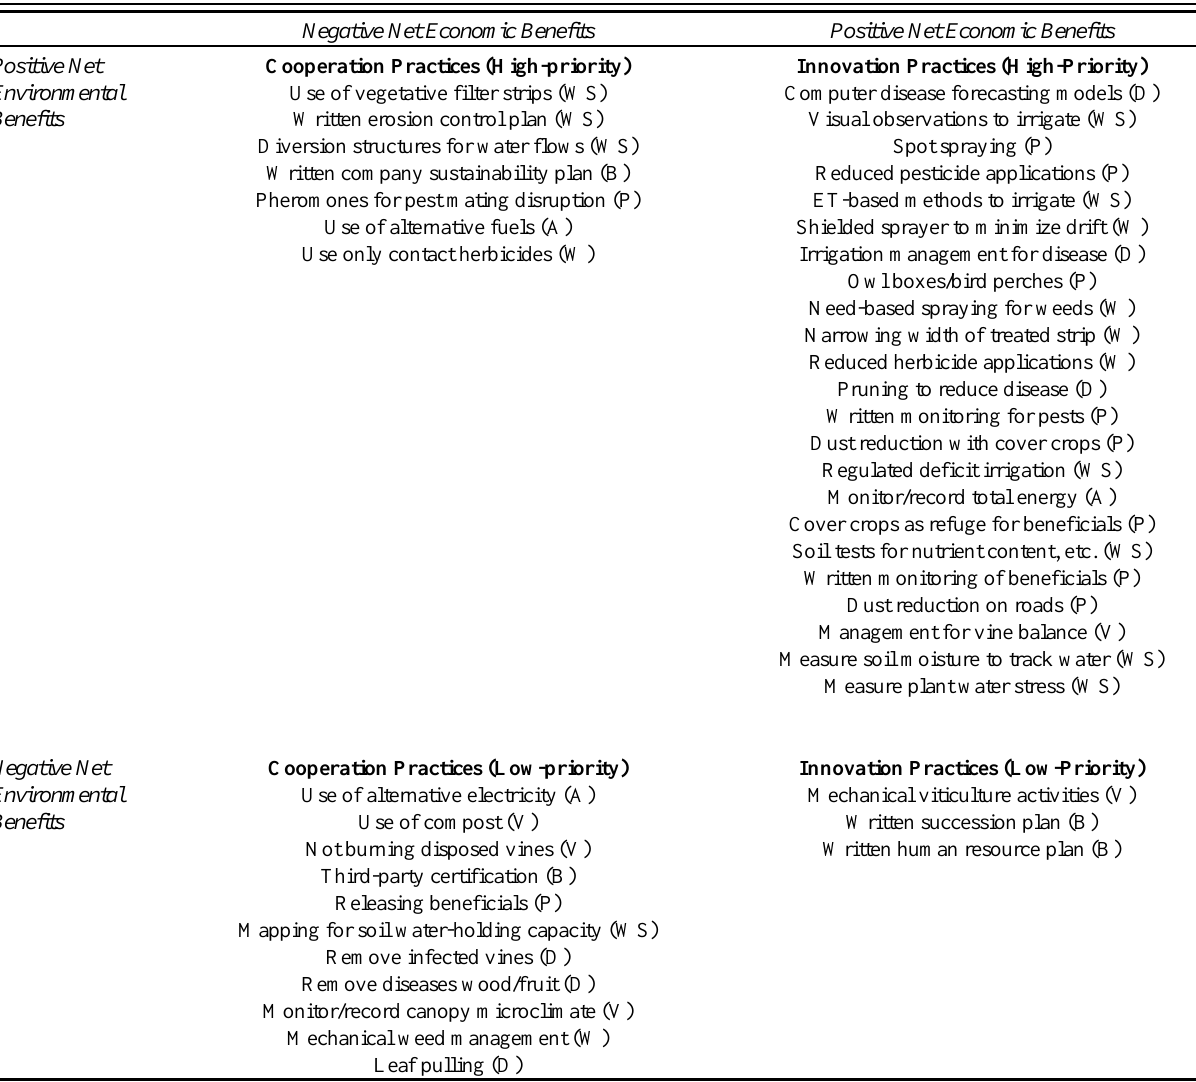
Table 1. Classification framework for viticulture